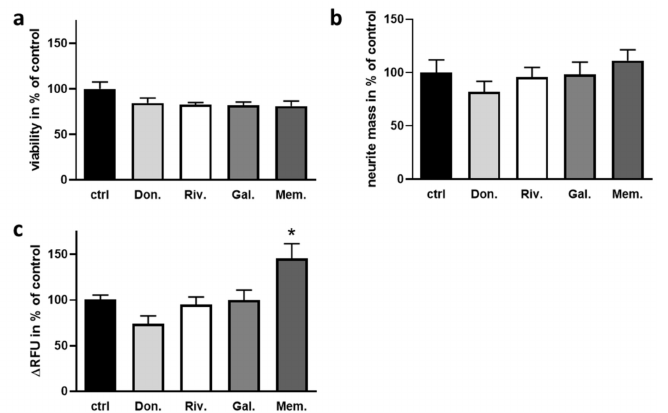
Figure 3. Influence of AChEI and memantine on enteric neurons. ( a ) Neurons were treated on DIV3 for 24 h with the indicated drug or DMSO as a solvent control (ctrl). Viability was analyzed by the CellTiter Glo assay ( n = 4 donor C57B6L/J wild type mice, aged 2–3 months). ( b ) Neurite mass was assessed after 24 h growth with the respective drug. Cells were cultivated on transwell plates and neurite mass determined after stripping off cell bodies by crystal violet stain ( n = 4 donor mice). ( c ) Calcium influx into enteric neurons treated for 25 min with the respective drugs or DMSO was measured by calcium-stain after KCl injection into the medium. Slope of the fluorescent signal in % of the solvent control is shown. ( n = 8–11 per group, 4 donor mice). Data are presented as mean + SEM. Statistical analysis was conducted by One Way ANOVA with Dunnett’s multiple comparison test (* p <